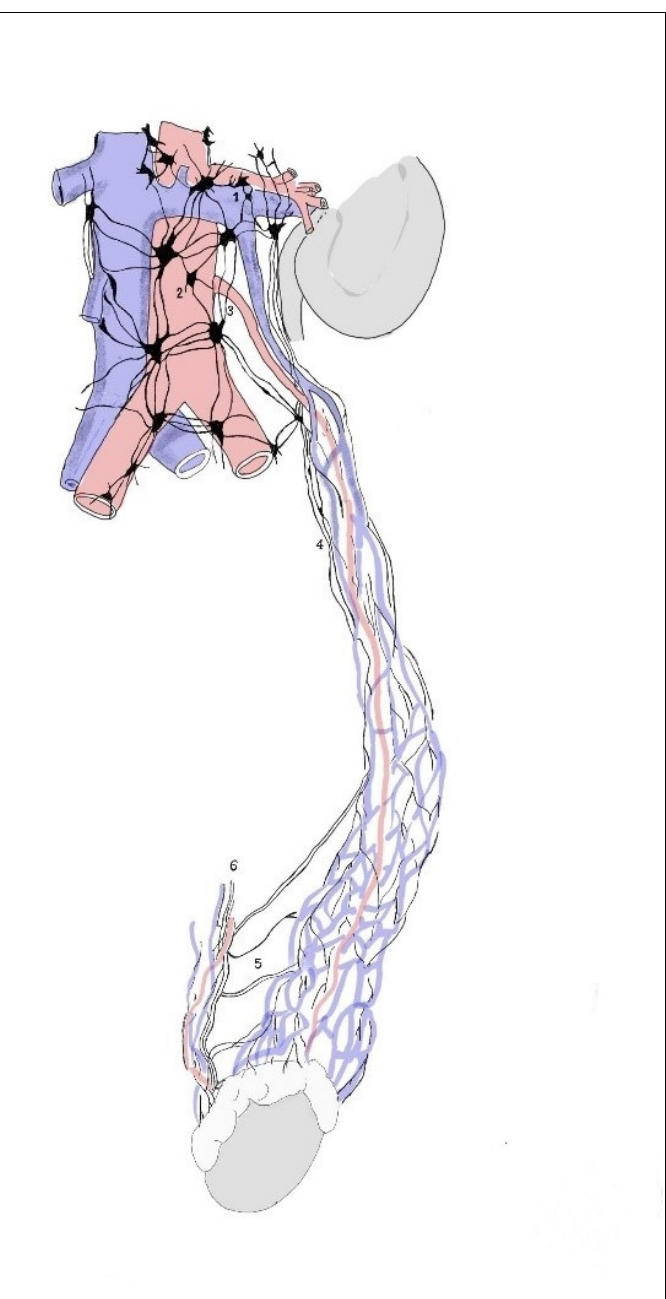
Figure 6. Differences in the structure of the spermatic plexus. In the segmental type, they consist of numerous small ganglia and nerves. They encircle the spermatic vasa in the form of networks, and the renal plexuses (1), aortic plexuses (2), mesenteric plexus (3), and other plexuses consist of many small nodules and nerves connected to each other; they surround the vasa spermatica and arise from the above-mentioned plexuses. In the course of the nerves (in their proximal part), it is possible to observe a large number of small ganglia (4). In the periphery of such a structure, one can observe many connections (5) with the deferential plexus